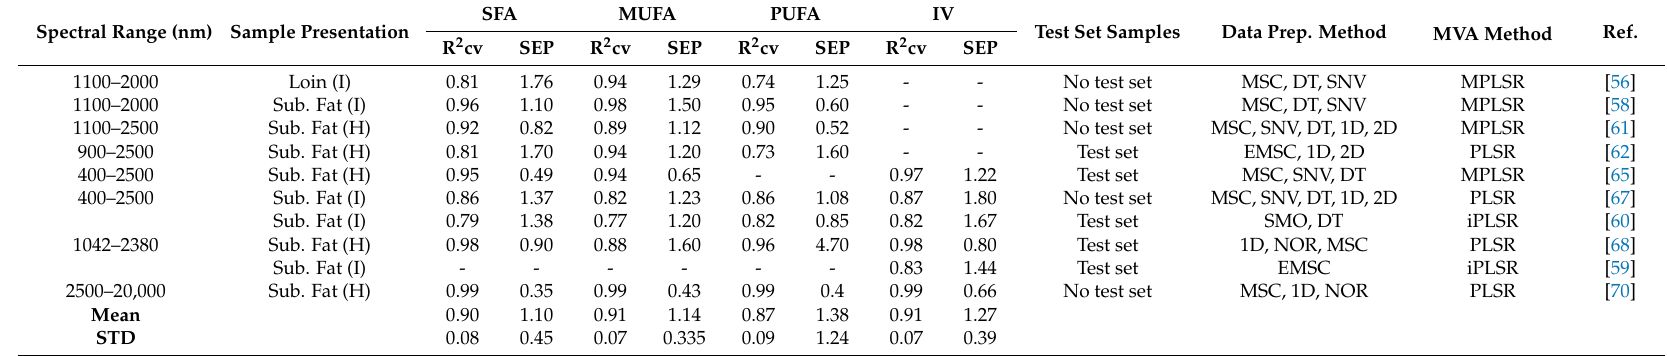
Table 3. Prediction of FA groups and IV in pork by NIRS. SFA: saturated fatty acids; MUFA: mono-saturated fatty acids; PUFA: polyunsaturated fatty acids; IV: iodine